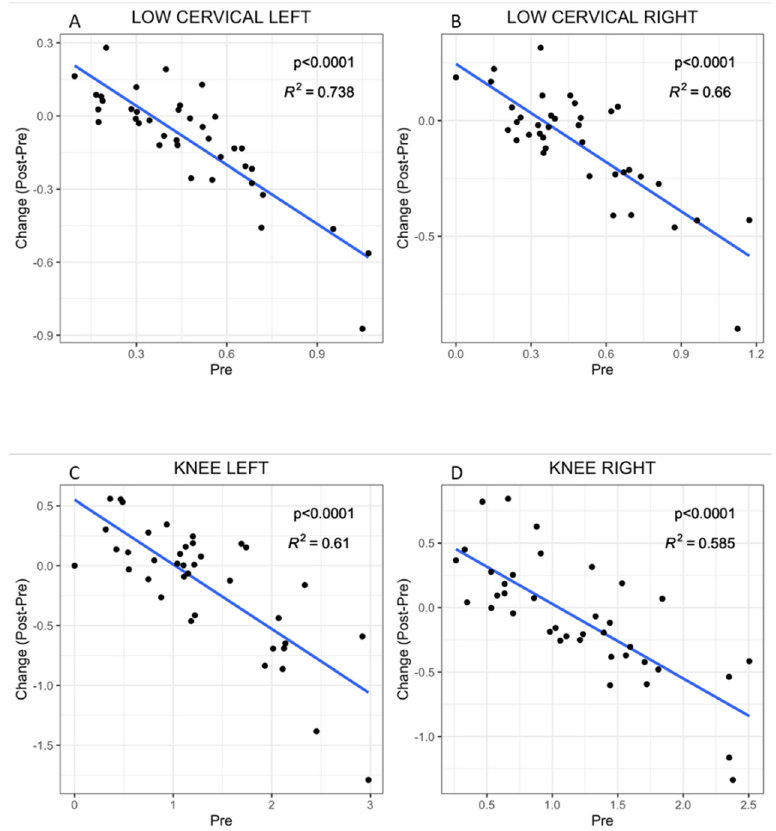
Figure 2. Linear dependence of PPT baseline scores with MT therapy response. The plots show the inverse correlation between pre-treatment PPT values and the improvement measured as the acquired resistance to pressure-induced pain for the tenderpoints (Change: Post–Pre) at the Low cervical left side of the body ( A ), or the right ( B ); and the same type of correlation for the tenderpoint at the left knee ( C ) or right knee ( D ). p and R2 values are shown.